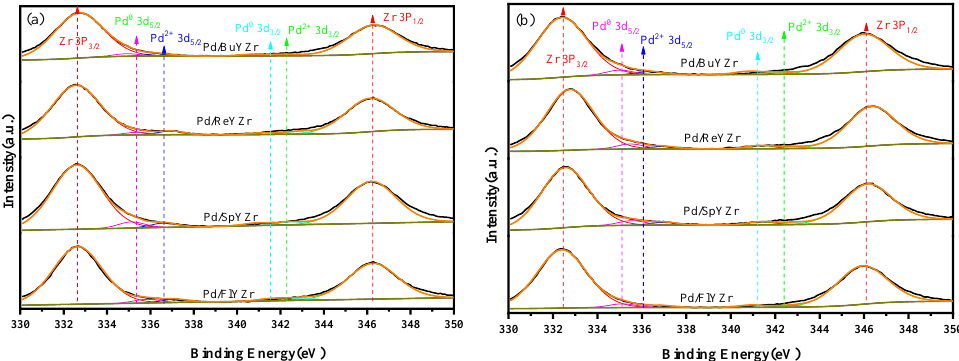
Figure 8. Pd 3d XPS spectra of fresh ( a ) and aged ( b ) Pd/Y-ZrO 2 catalysts with different morpholo- gies.